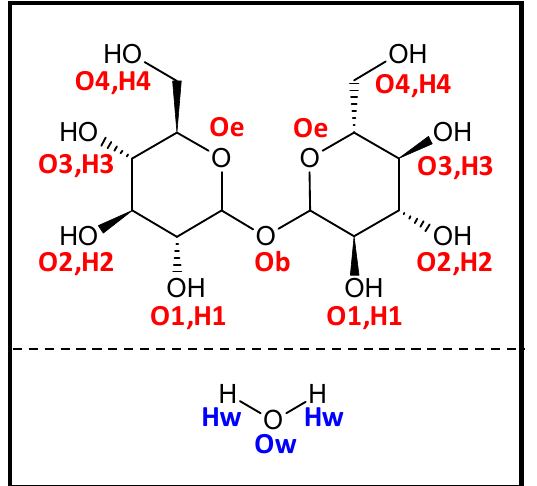
Figure 1. Structure of Trehalose (THAL) and water molecules with atom labelling used in this